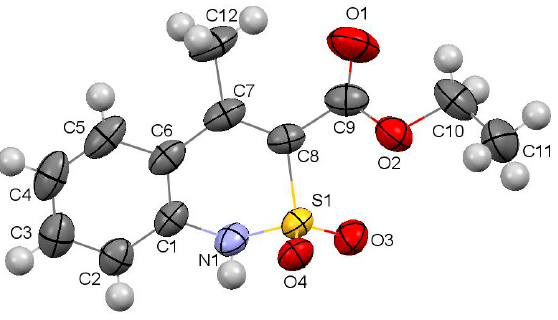
Figure 3. The spatial structure of ethyl ester 2 according to the X-ray diffraction data. The atoms are represented by thermal vibration ellipsoids of 50% probability.